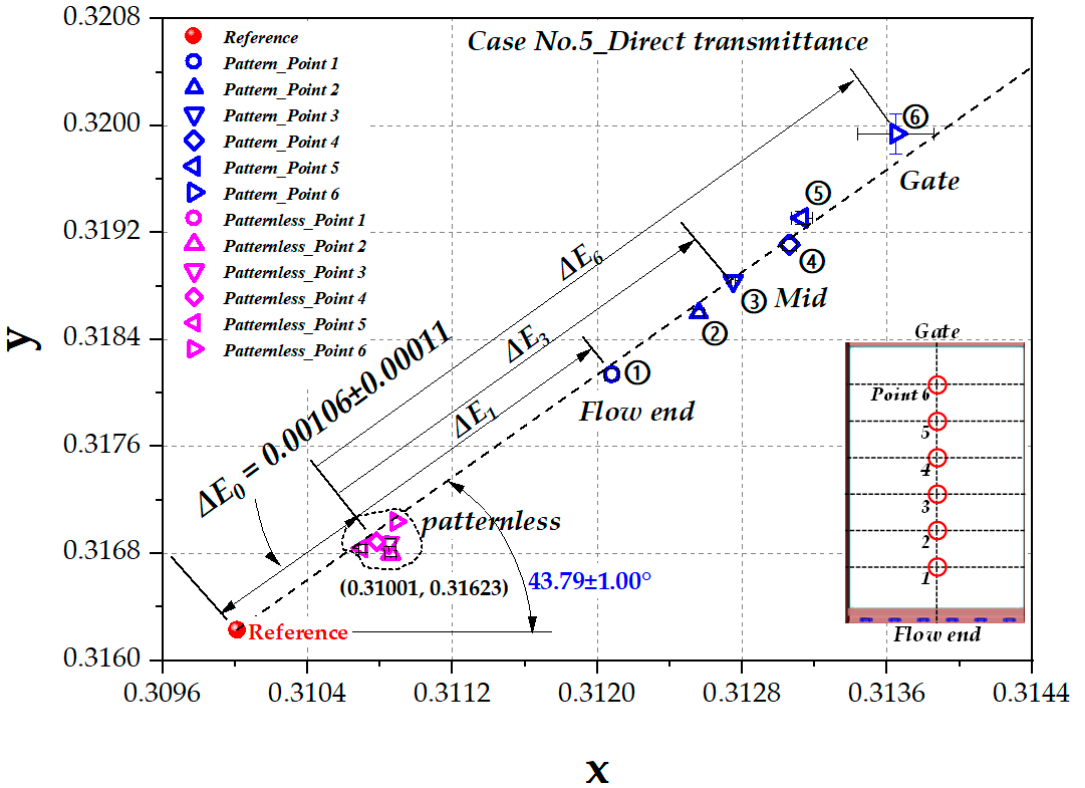
Figure 10. The representation of color shift from direct transmittance shown in CIE1931 color space of patternless and patterned LGPs (Case No. 5).